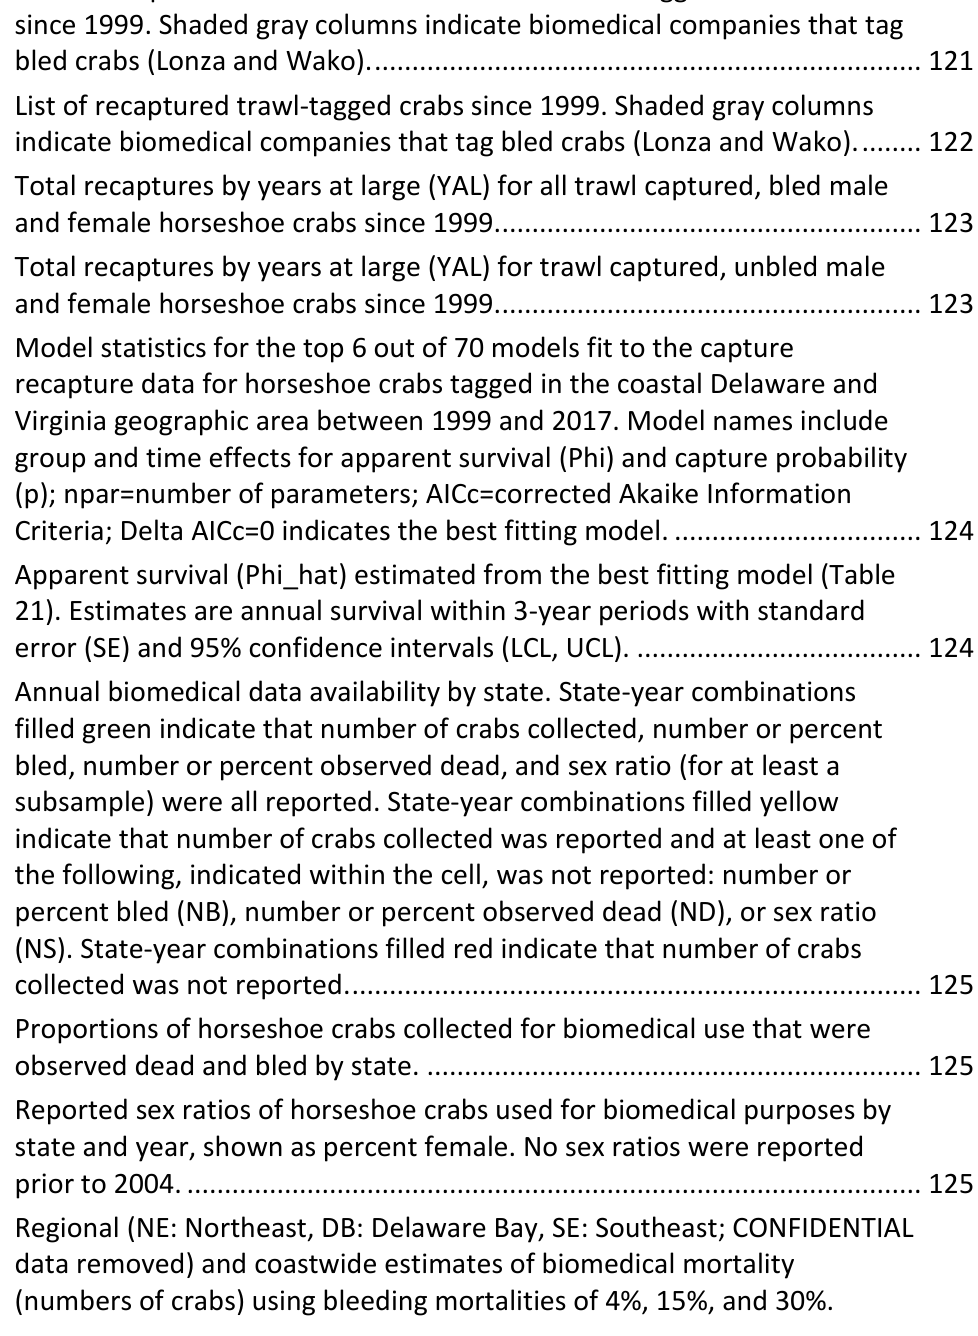
2019 Horseshoe Crab Benchmark Stock Assessment Non-Confidential Report